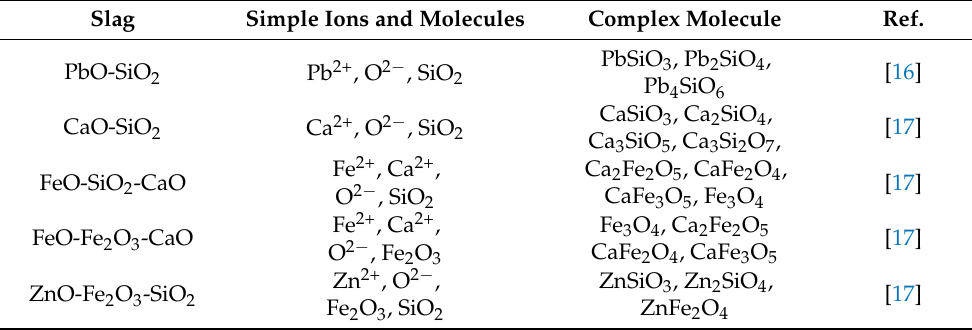
Table 1. Structural unit of the PbO-ZnO-FeO-Fe 2 O 3 -SiO 2 -CaO slag system. Slag Simple Ions and Molecules